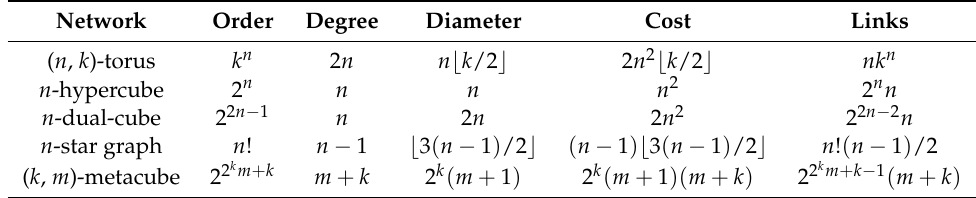
Table 1. Comparing torus topological properties with other popular interconnection networks [9]. Network Order Degree Diameter Cost Links ( n , k )-torus k n 2 n n (cid:98) k /2 (cid:99) 2 n 2 (cid:98) k /2 (cid:99) nk n n -hypercube 2 n n n n 2 2 n n n -dual-cube 2 2 n − 1 n 2